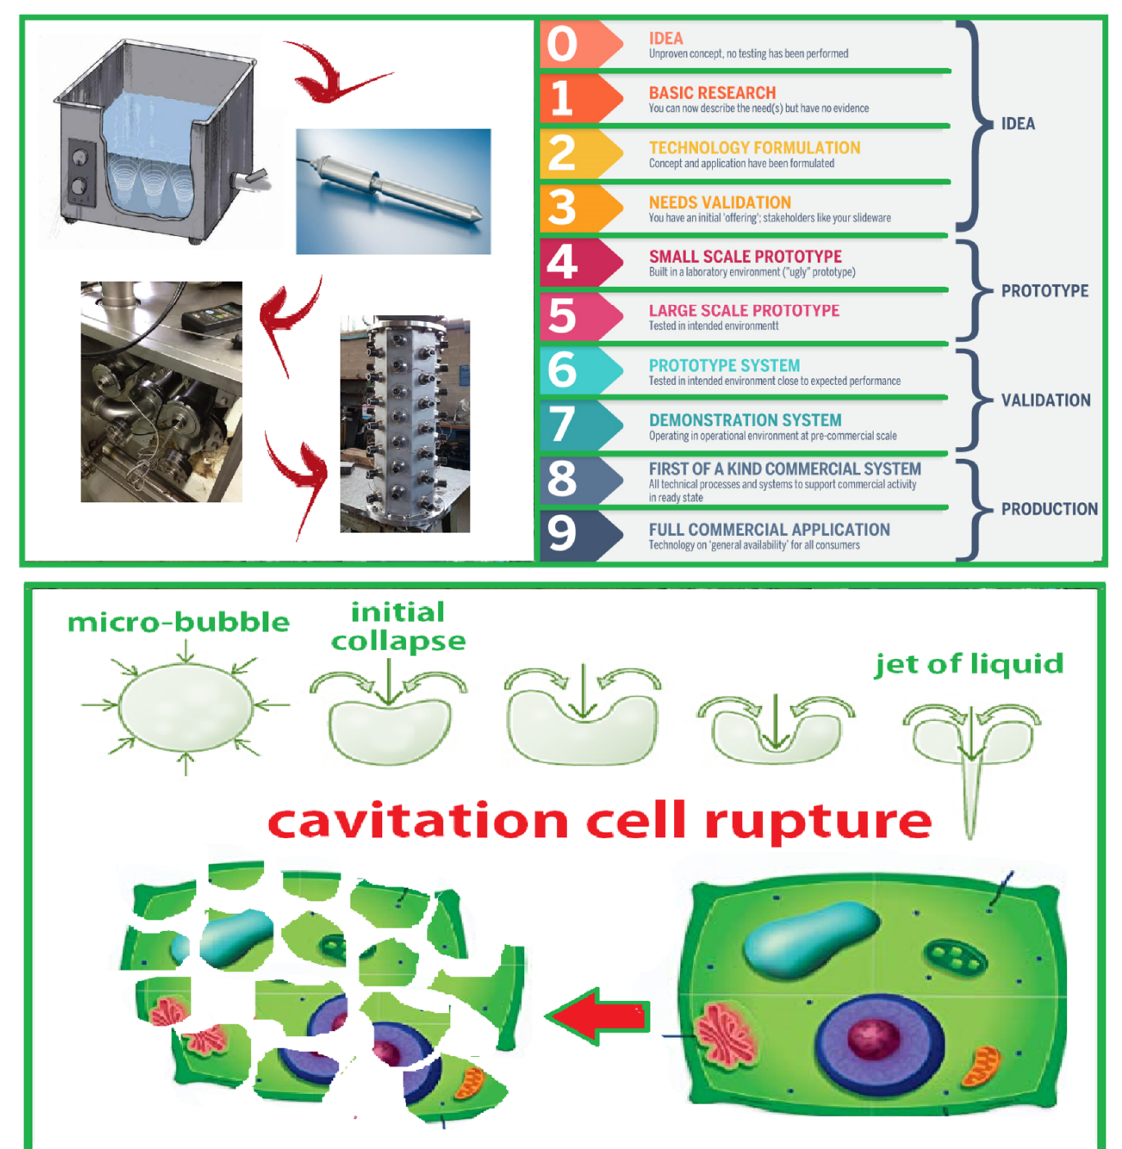
Figure 1. The long, complex, and difficult journey to pass from the basic concept of an idea to a commercially available product, the TRL (Technology Readiness Level) definitions, and the mechanisms of cell rupture due to cavitation phenomena. of cell rupture due to cavitation